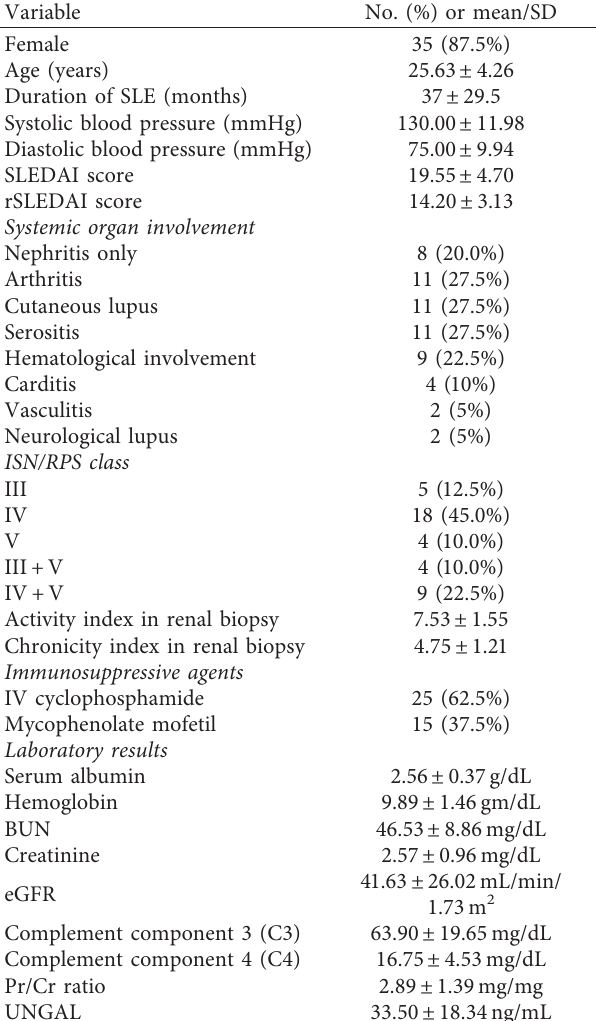
Table 1: Patients’ characteristics and laboratory